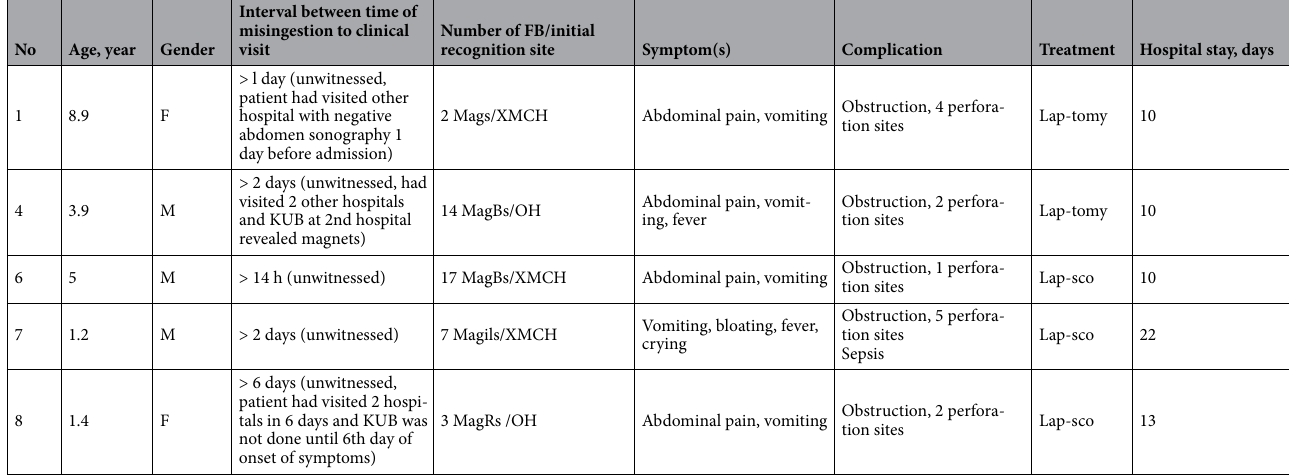
Table 1. Clinical characteristics of 5 children with unwitnessed/non-self-reported magnetic foreign body misingestion in children. FB foreign bodies, Mag magnet, MagB magnet bead, XMCH Xiamen